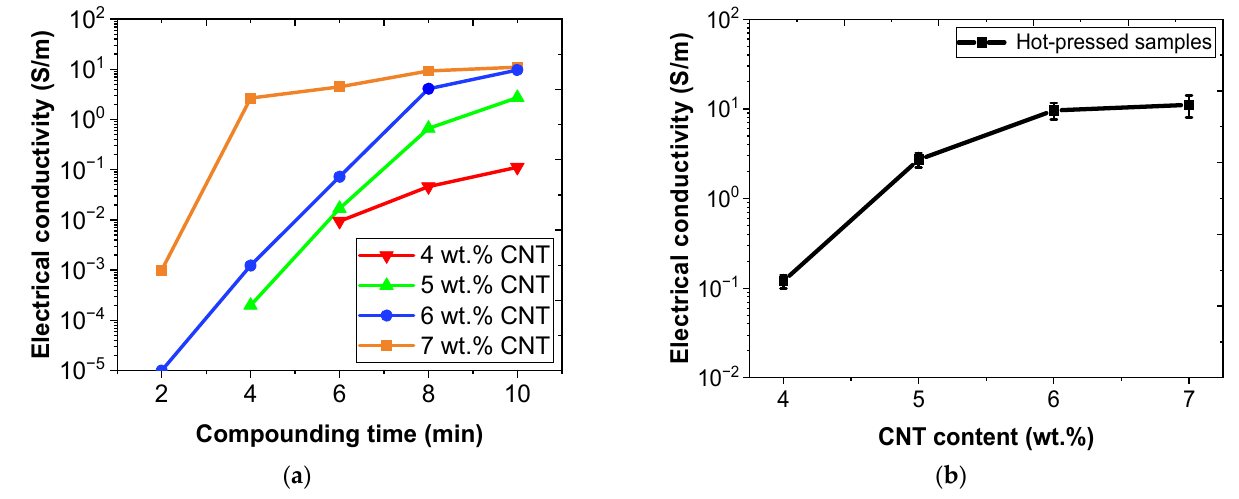
Figure 3. Electrical conductivity measurements of ( a ) extruded filaments at different compounding times and ( b ) hot-pressed samples as function of CNT content.